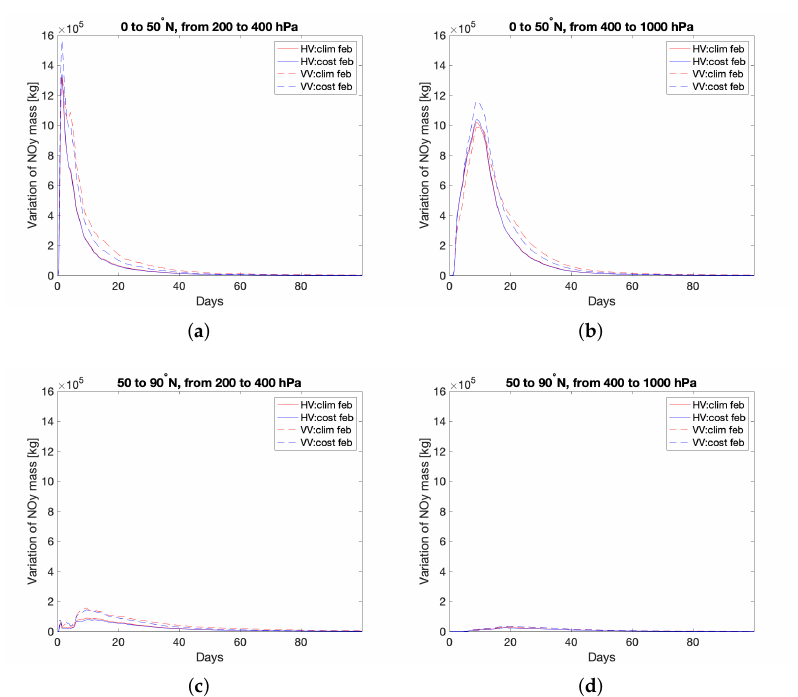
Figure 15. Time series of NO y atf mass [kg(N)] in specific regions from chemistry–climate simulations starting on 1 February 2016. The red and blue lines indicate the climate-optimised and cost-optimised cases, respectively, and the panel titles in ( a – d ) indicate the investigated regions.